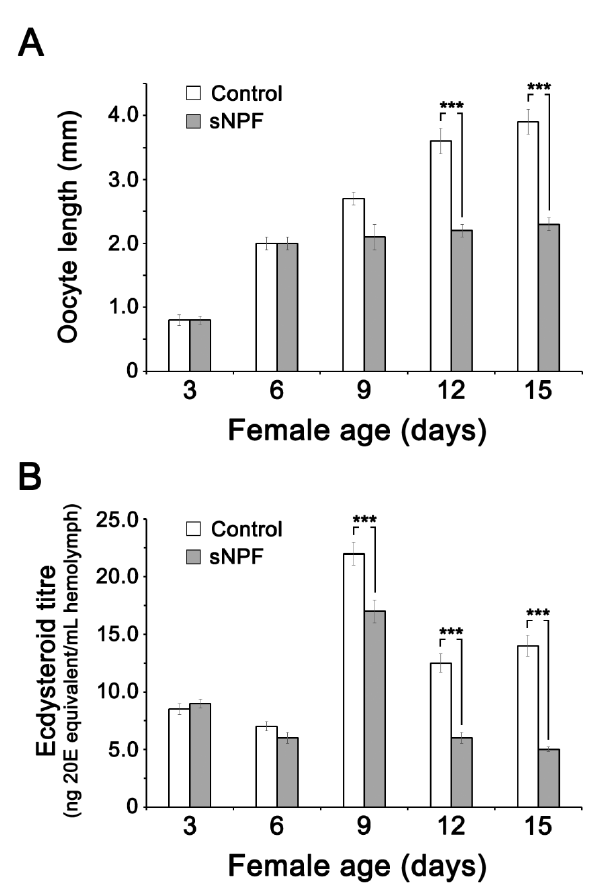
Figure 4. E ff ect of sNPF treatments on oocyte size and 20E titers in hemolymph. ( A ) E ff ect of sNPF injection on oocyte size in adult females. Adult females were injected daily with 10 pmol sNPF (dissolved in 5 µ L PBS), from day 1 to day 15 of the adult stage. Control insects were injected with 5 µ L PBS into the hemolymph. ( B ) E ff ect of sNPF injections on ecdysteroid concentrations in the hemolymph. A total 10 pmol of sNPF (in 5 µ L of PBS) was injected daily into the hemocoel of female adults from day 1 to day 15. Control insects were injected with 5 µ L of PBS. Ecdysteroid level was measured by the EIA. Values are displayed as mean ± SEM ( n = 25 individual / condition). ***: significantly di ff erent ( p < 0.001) compared to the controls, using Tukey’s